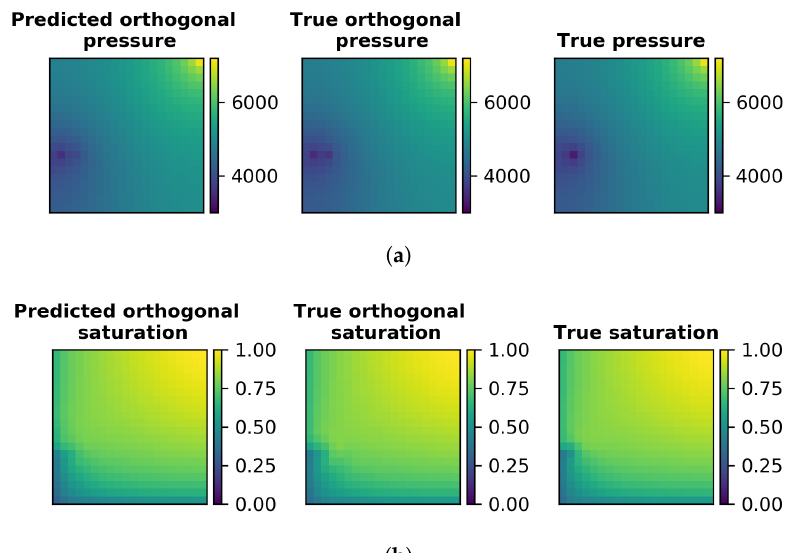
Figure 20. Comparison of predicted orthogonal and true orthogonal solutions with true solution at time = 360 days for ( a ) Pressure and ( b )